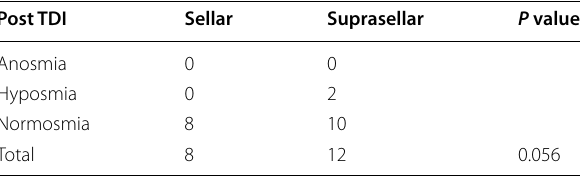
Table 5 Postoperative smell outcome categorized co-relation with tumor location using Fisher Exact